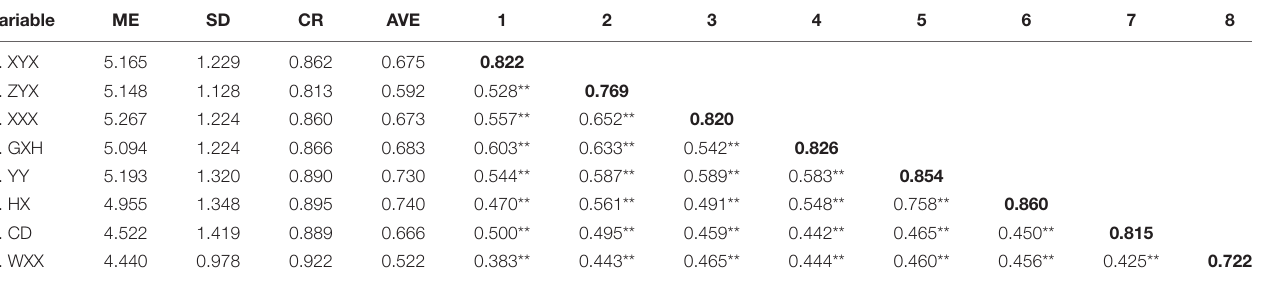
TABLE 3 | Discriminant validity analysis of measurement model. Variable